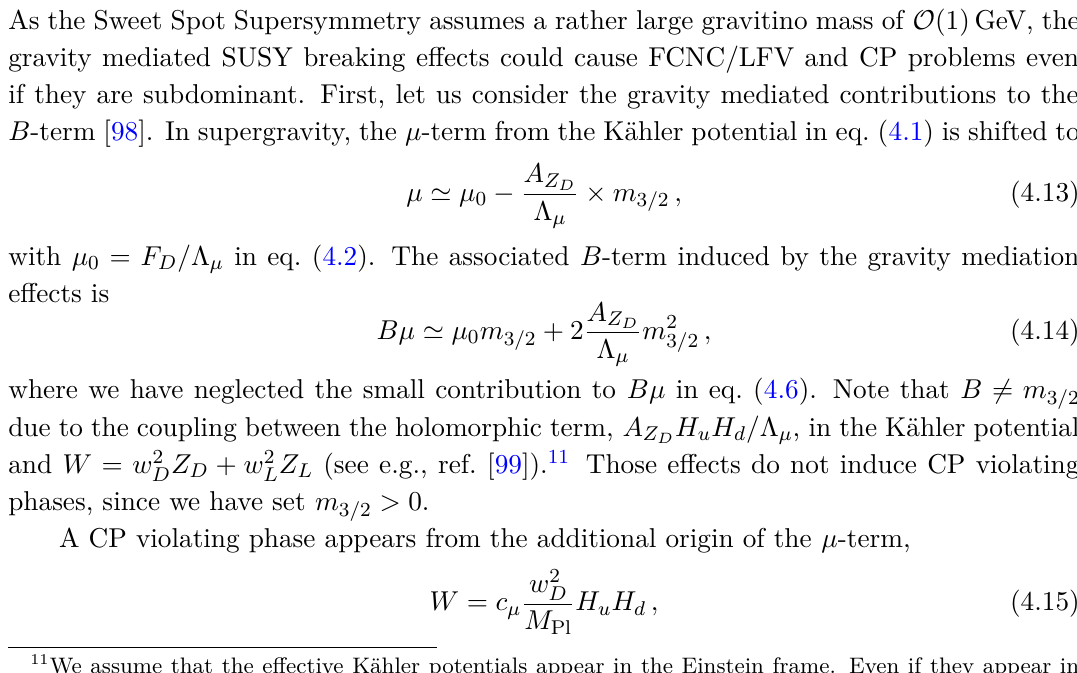
Figure 4. (a): posterior distribution of the SUSY parameters consistent with a µ , the Higgs mass and vacuum stability bound. We choose the parameter points at which m and a 19 . 2 × 10 − 10 . (b): posterior distribution with the LHC and LEP constraints (see µ | SUSY > section 5). In both cases, the predicted tan β is typically ∼ 30 − 40